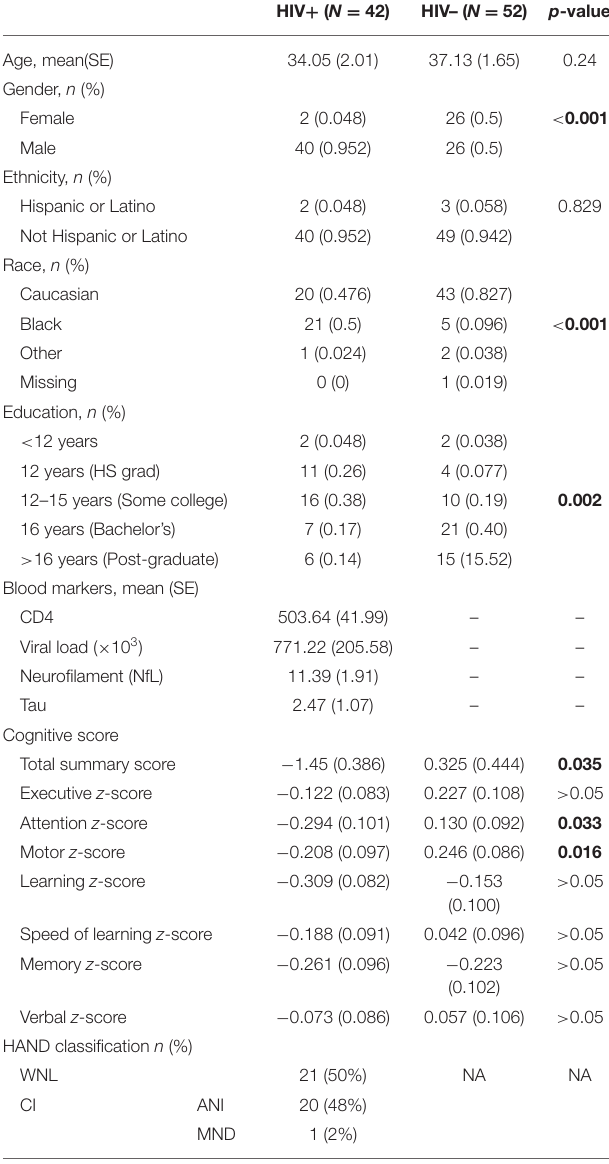
TABLE 1 | Participant demographics, clinical, and cognitive